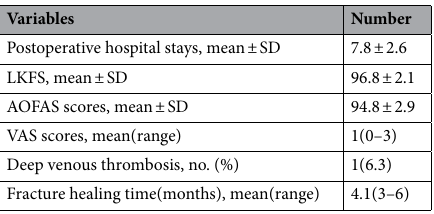
Table 3. Prognostic comparison. SD standard